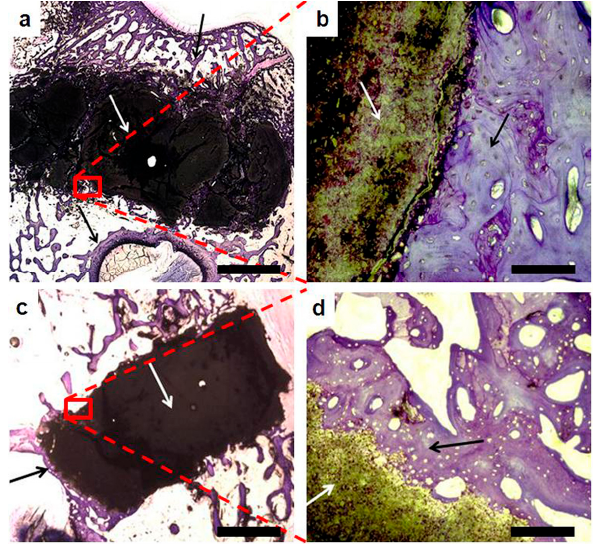
Figure 9. Optical microscopic view of explanted Sr2 ( a , b ) and KyphOs ( c , d ) at four weeks after implantation. Cements and surrounding bone are indicated with white and black arrows, respectively. Scale bars ( a , c = 2 mm; b , d = 100 µm).